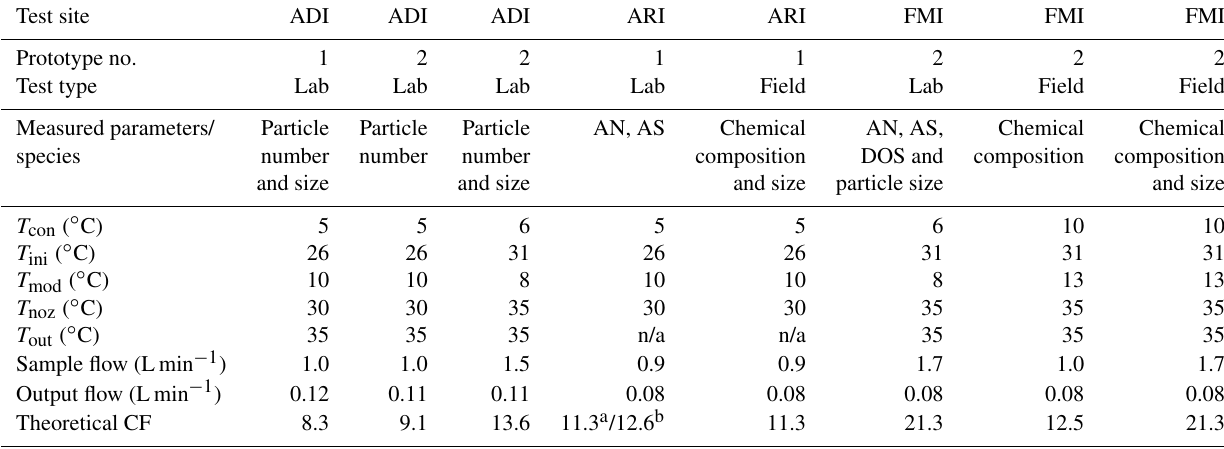
Table 1. Approximate temperature and flow settings for the ADIc experiments presented in this study. ADI represents Aerosol Dynamics Inc., ARI Aerodyne Research, Inc. and FMI the Finnish Meteorological Institute. T con , T ini , T mod and T noz are the operating temperatures for the conditioner, initiator, moderator and focusing nozzle, respectively. AN, AS and DOS are abbreviations for ammonium nitrate, ammonium sulfate and dioctyl sebacate, respectively. n/a denotes measurements that are not available. Test site ADI ADI ADI ARI ARI FMI FMI FMI Prototype no. 1